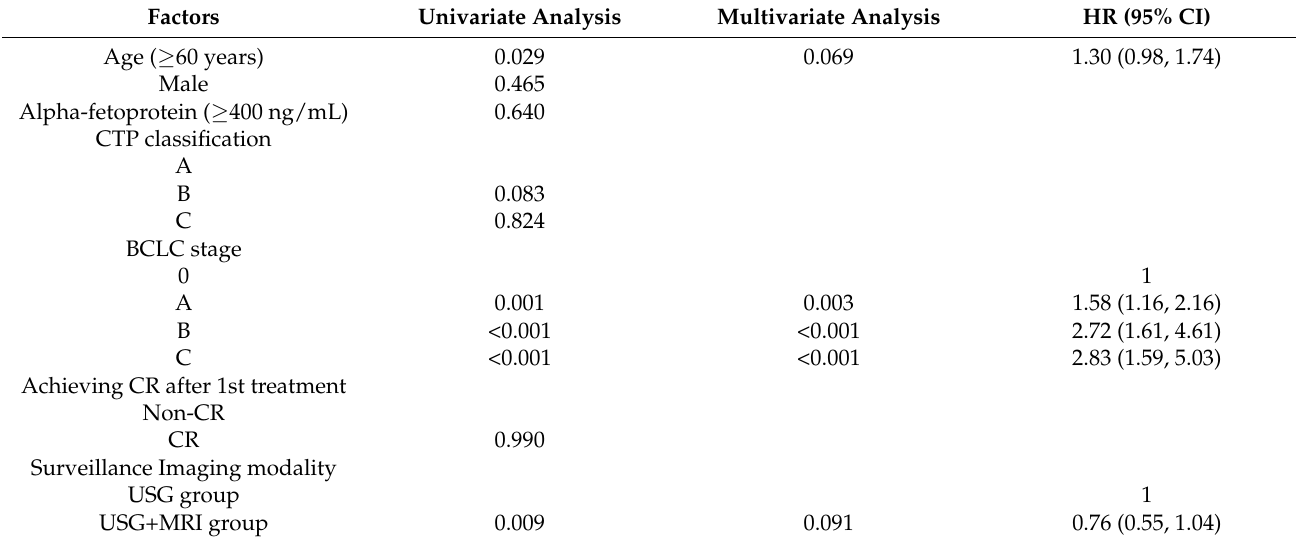
Table 3. Factors affecting the time to